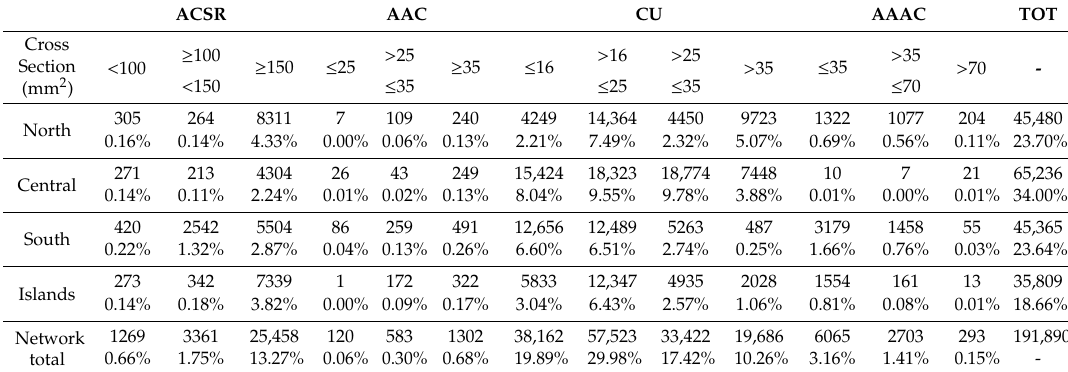
Table 4. Detail of the distribution network (MV and LV) main wire types extension in (km) and in (%) respective to the total